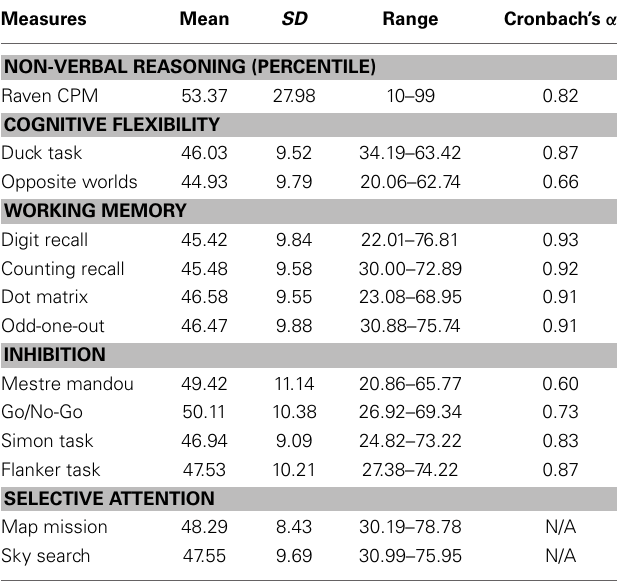
Table 3 | Descriptive statistics for non-verbal reasoning and executive function scores ( N =